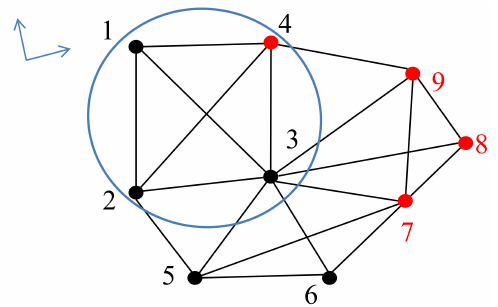
Figure 3. An illustration of graph G and its decomposition. The black nodes indicate those agents that can sense the distance measurements while the red ones indicate agents of sensing the bearing measurements. For instance, the blue circle shows one subgraph containing agents 1,2,3 and 4, which is stiff. Along with it, G is separated into several subgraphs as follows: {1, 2, 3, 4}, {3, 4, 9}, {3, 7, 8, 9}, {2, 3, 5, 6,